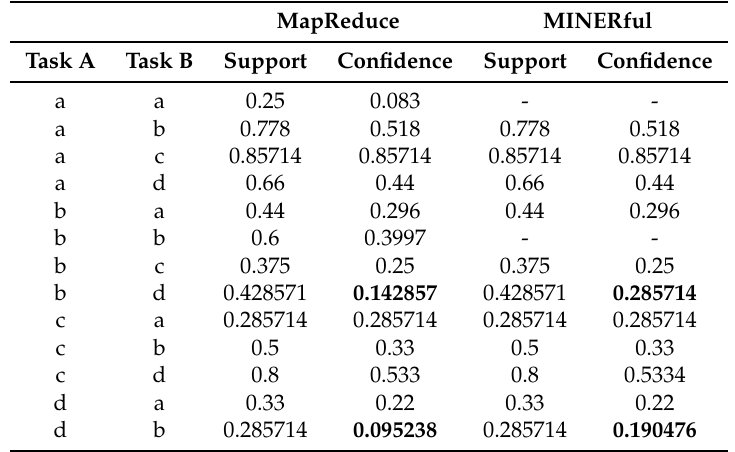
Table 22. Discovered single-perspective Succession Constraints with MapReduce and MINERful. MapReduce MINERful Task A Task B Support Confidence Support Confidence